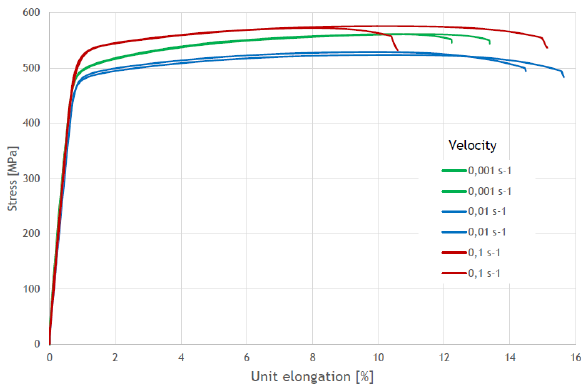
Figure 1: Stress-strain curve for aluminium alloy